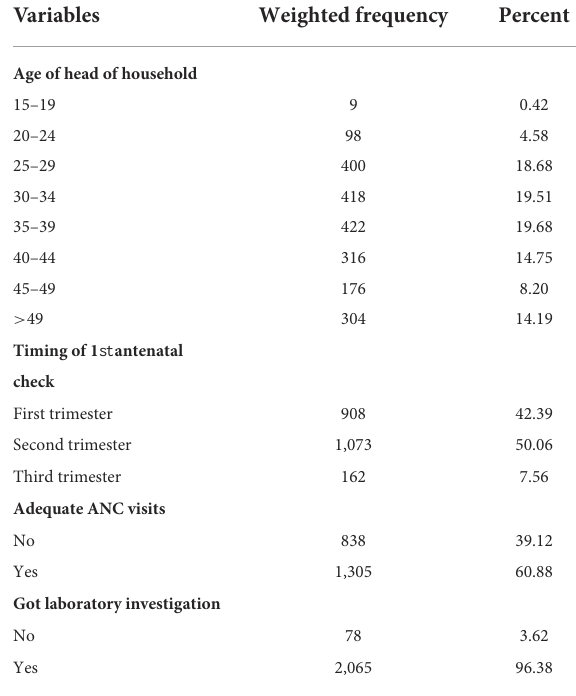
TABLE 1 Background characteristics of women who have ANC follow up in Ethiopia, 2019 EMEDHS, ( N =